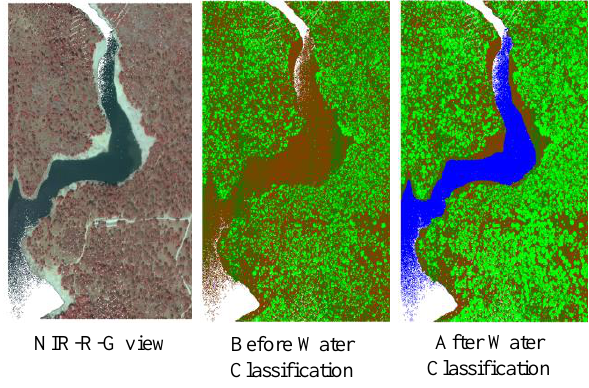
Figure 4 – Result example of a water area During the process of reclassification it is also obtained a polygon layer of the resulting water body contours with an elevation attribute. To digitize the contour it is necessary to erase class 9-water and get the polygon of the hole. This polygon is used later to fill the DTM with a constant Z in those regions where there is no point cloud